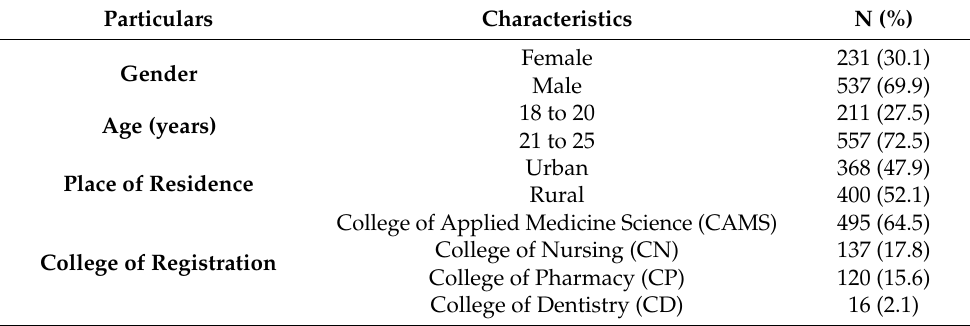
Table 1. Demographic characteristics of the respondents of the survey (N = 768). Particulars